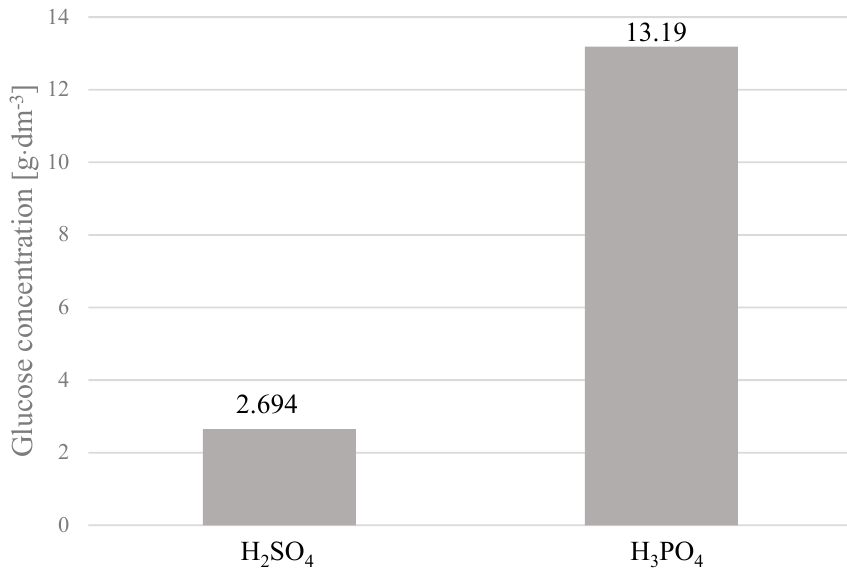
Figure 14. Glucose concentration in hydrolysates, depending on the type of acid used. Reaction conditions: 2 h, 140 ◦ C, 2% H 2 SO 4 or 2% H 3 PO 4 . Glucose concentrations were the arithmetic means of the results obtained in the three hydrolysis processes with the standard deviations: 2.694 ± 0.172; 13.19 ± 0.475.